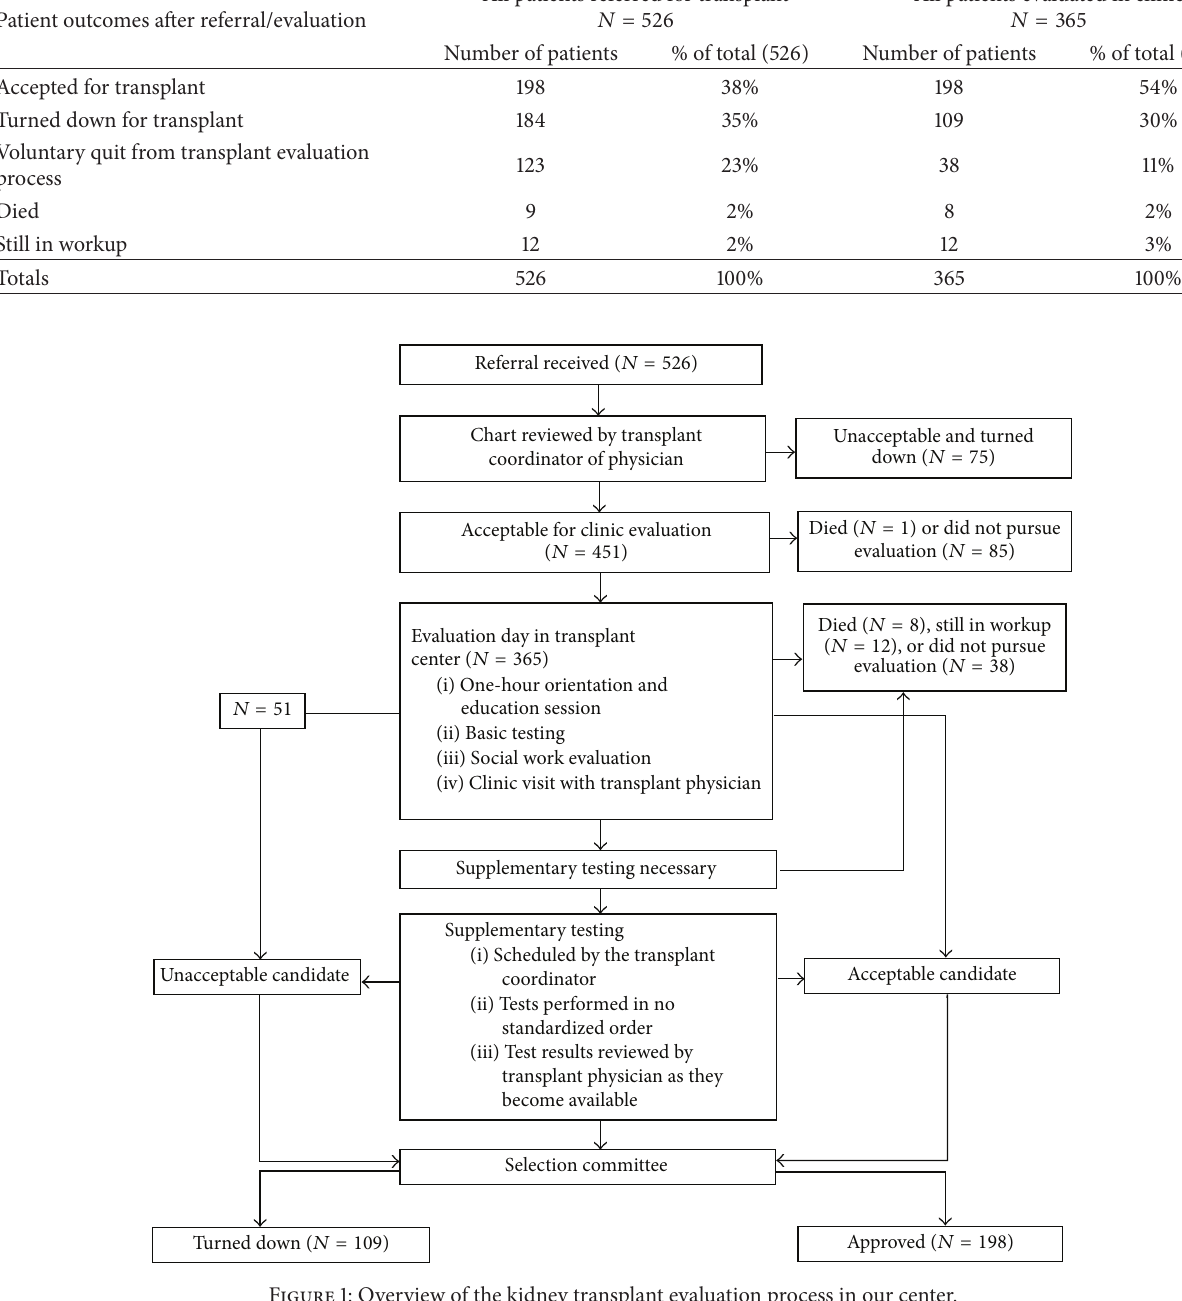
Figure 1: Overview of the kidney transplant evaluation process in our